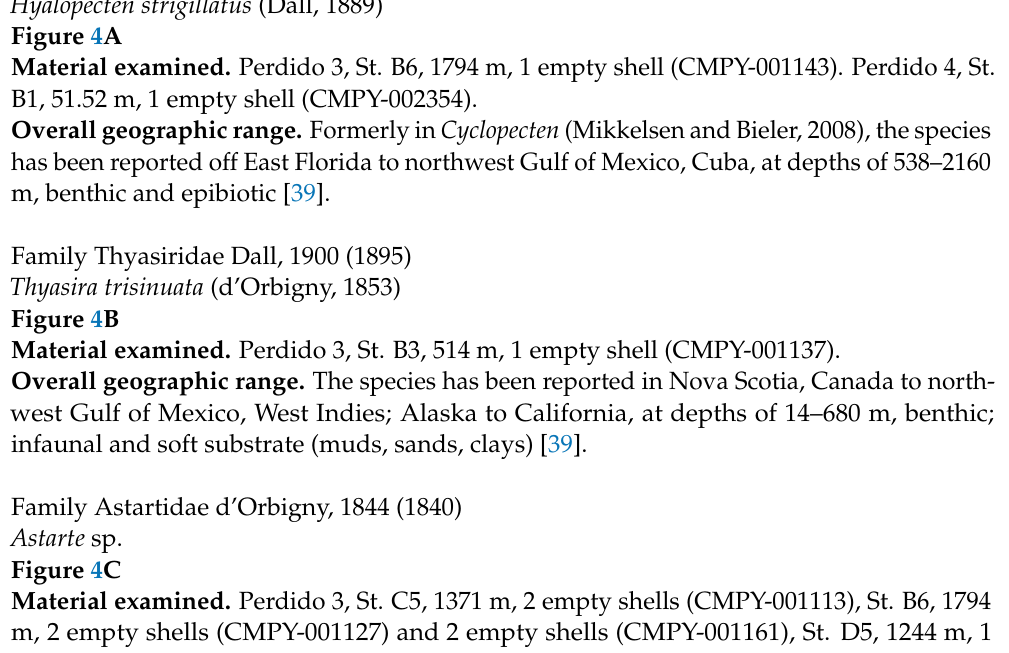
Material examined. Perdido 3, St. B6, 1794 m, 1 empty shell (CMPY-001143). Perdido 4, St. B1, 51.52 m, 1 empty shell (CMPY-002354). Overall geographic range. Formerly in Cyclopecten (Mikkelsen and Bieler, 2008), the species has been reported off East Florida to northwest Gulf of Mexico, Cuba, at depths of 538–2160 m, benthic and epibiotic [39].